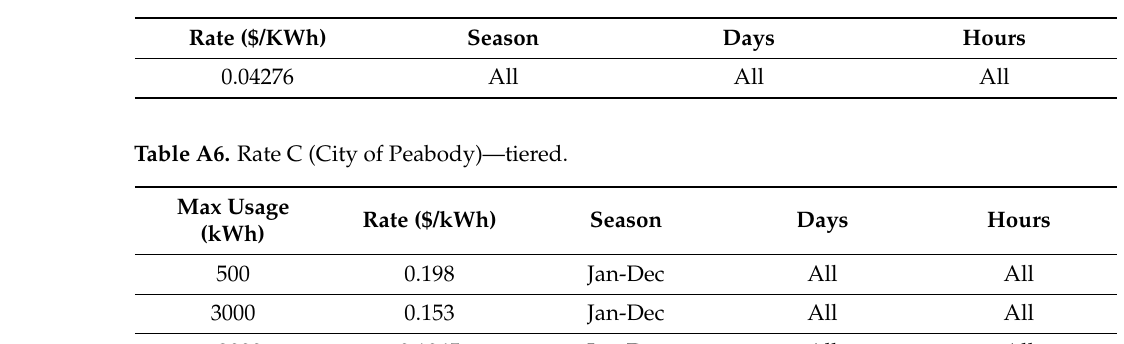
Figure A3. Rate A (Town of Wellesley)—time-of-use. Table A5. Rate B (Town of Danvers)—flat.